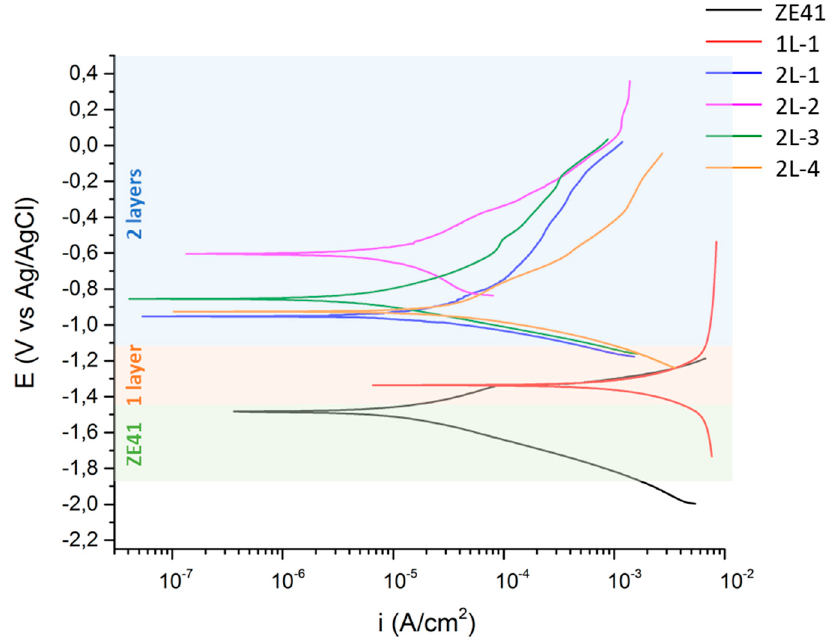
Figure 12. Anodic-cathodic polarization curves after 1 h immersion in NaCl 3.5 wt.% of the uncoated ZE41 magnesium alloy and the WC-Co-coated systems.